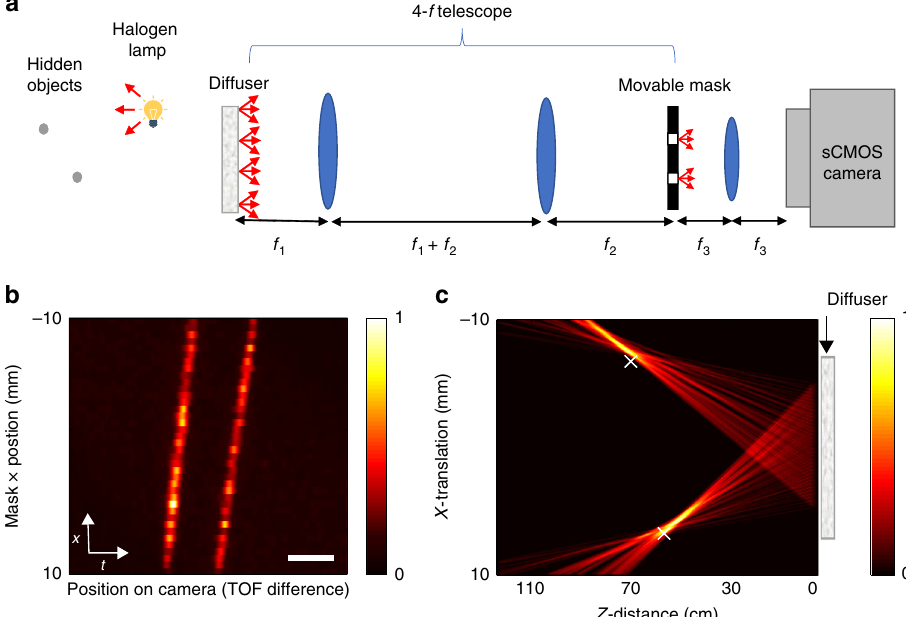
Fig. 5 Localizing hidden re fl ective objects. a Setup (top view): two hidden metallic objects are illuminated by a halogen lamp (Thorlabs OSL2). The re fl ected light passing through a highly scattering diffuser is interfered on a camera by a movable double-aperture mask. b Interference fringes envelope as a function of the mask position, providing the TOF information. c Scene reconstructed from ( b ) revealing the sources positions. The objects ’ real positions are marked by ‘ x ’ . Scale bar: 100